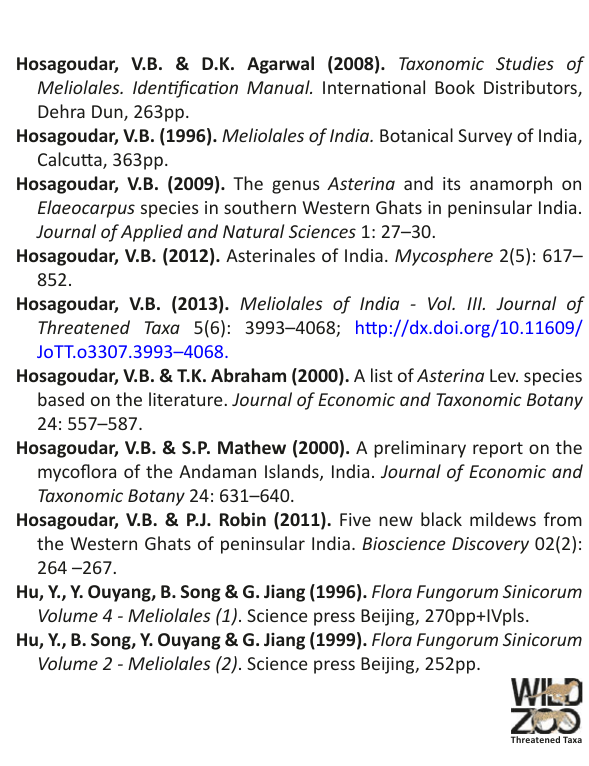
Figure 18. Schiffnerula chukrasiae sp. nov. a - Appressoriate mycelium; b - Conidia of Sarcinella ; c - Germinating conidia of Questieriella ; d - Thyriothecium; e - Colony forming